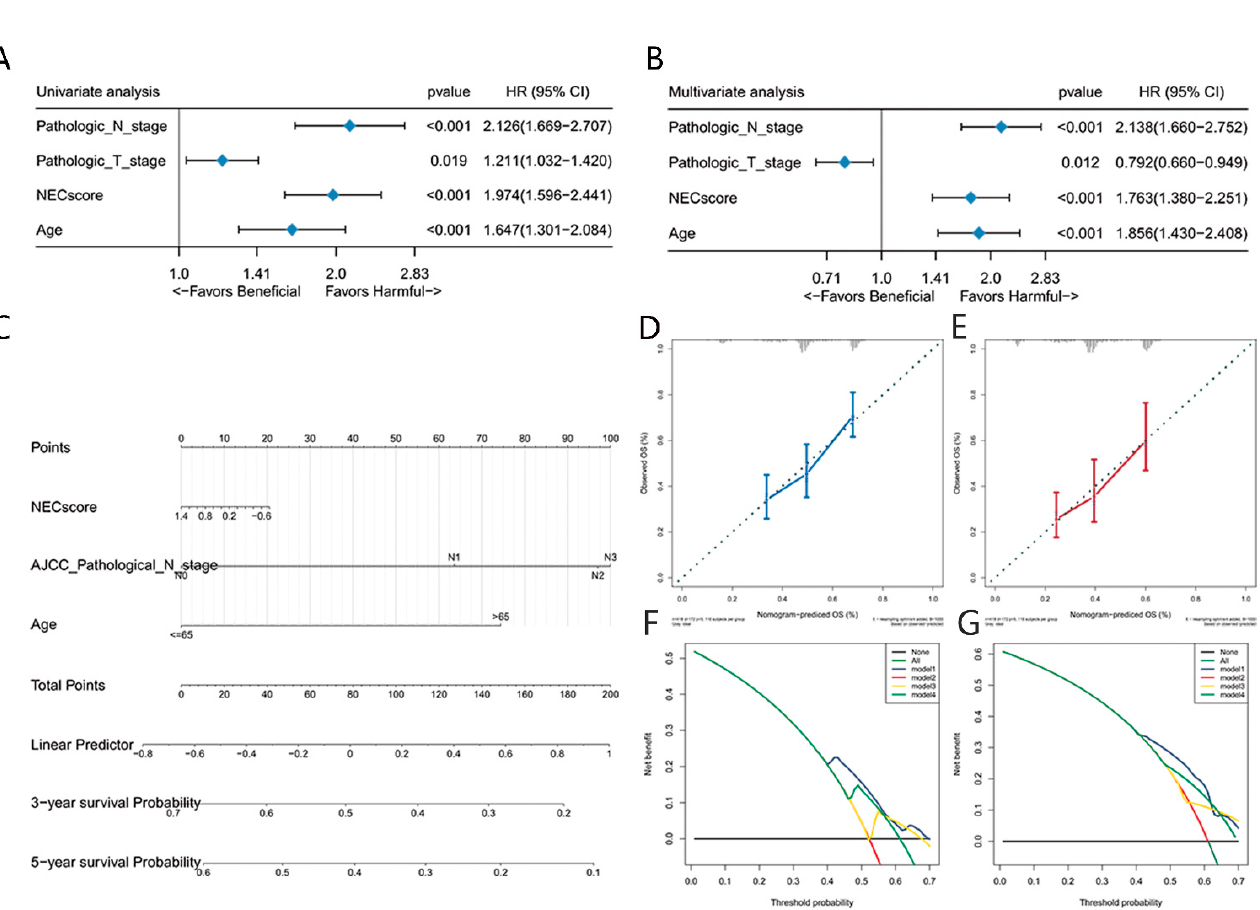
Figure 4. NEC score is an independent prognosis factor in the nomogram. ( A , B ) Forest plot summary of the univariate ( A ) and multivariate ( B ) Cox analyses of the NEC score and clinicopathological characteristics. The results indicate four independent prognosis factors: age, pathologic T stage, pathologic N stage and NEC score. The blue diamond squares on the transverse lines represent the HR, and the black transverse lines represent the 95% confidence interval (CI). The p value and 95% CI for each clinical feature are displayed in detail. ( C ) Nomograms for predicting the probability of patient mortality at 3 or 5 year OS based on five independent prognosis factors. ( D , E ) Calibration curves of the nomogram for predicting the probability of OS at 3 and 5 years. ( F , G ) Decision curve analyses (DCAs) of the nomograms based on five independent prognosis factors for 3-year and 5-year risk.